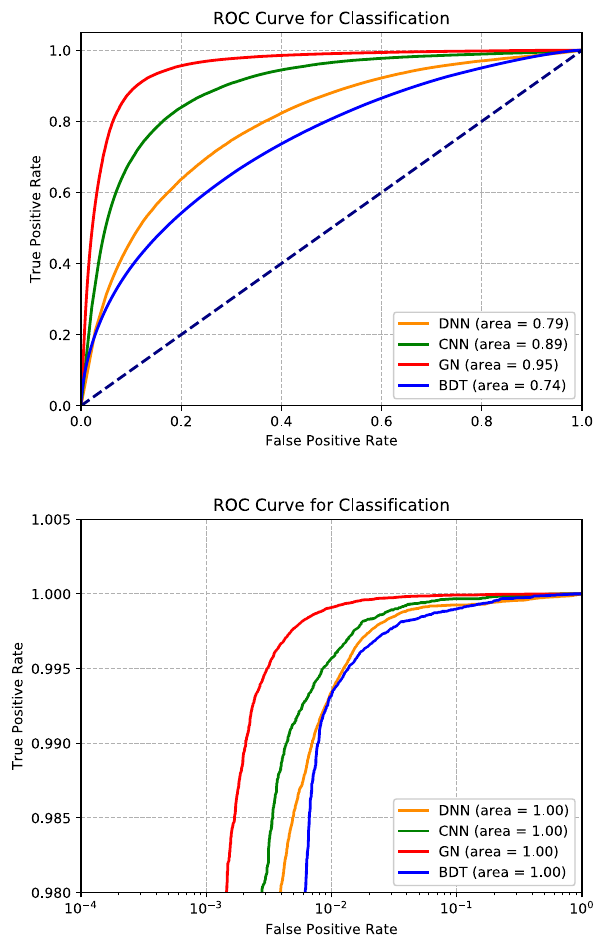
Fig. 13 ROC curve comparisons for γ vs. π 0 (top) and e vs. π ± (bot- tom) classification using DNN, CNN, BDT, and GoogLeNet (GN). Samples include particle energies from 2 to 500 GeV, and an